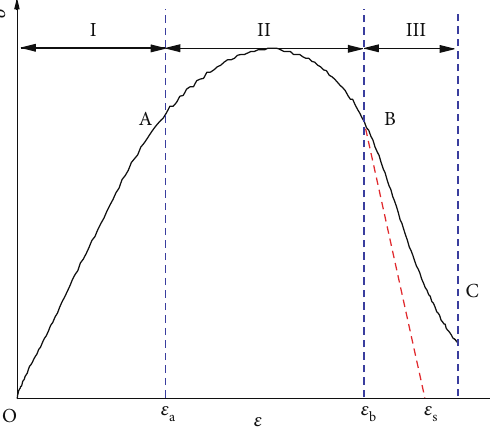
Figure 5: Damage evolution of